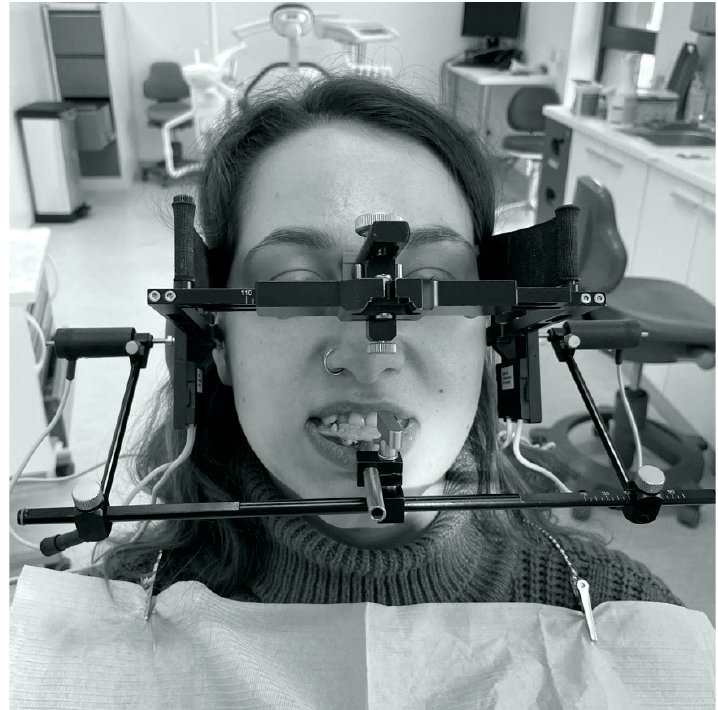
Figure 1. Condylography using the Cadiax Compact—front image.